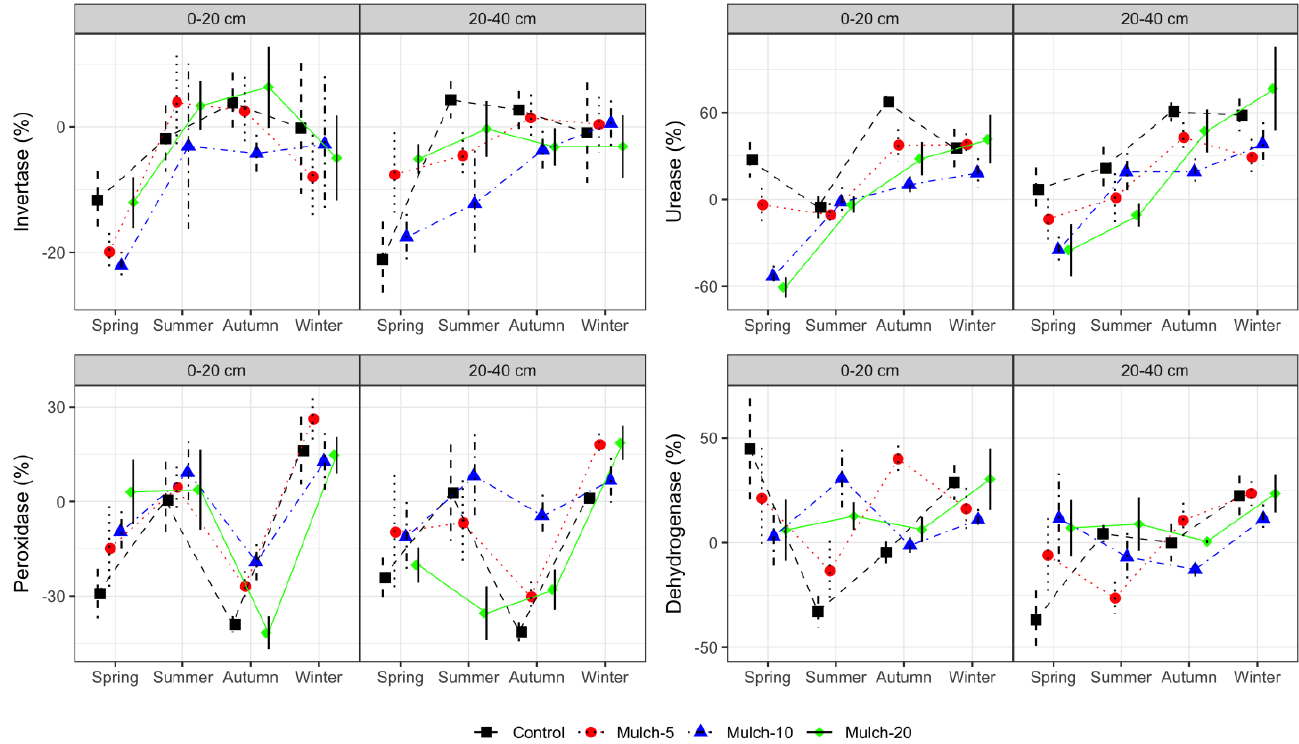
Figure 2. Differences in enzyme activities between the rhizosphere and bulk soil based on organic mulching. Values represent mean ± standard error ( n = 5). Values above the 0 line indicate higher enzymatic activity in the rhizosphere than in the bulk soil. Treatments: Mulch-5, Mulch-10, and Mulch-20, corresponding to organic mulching to a depth of 5, 10 and 20 cm, respectively.